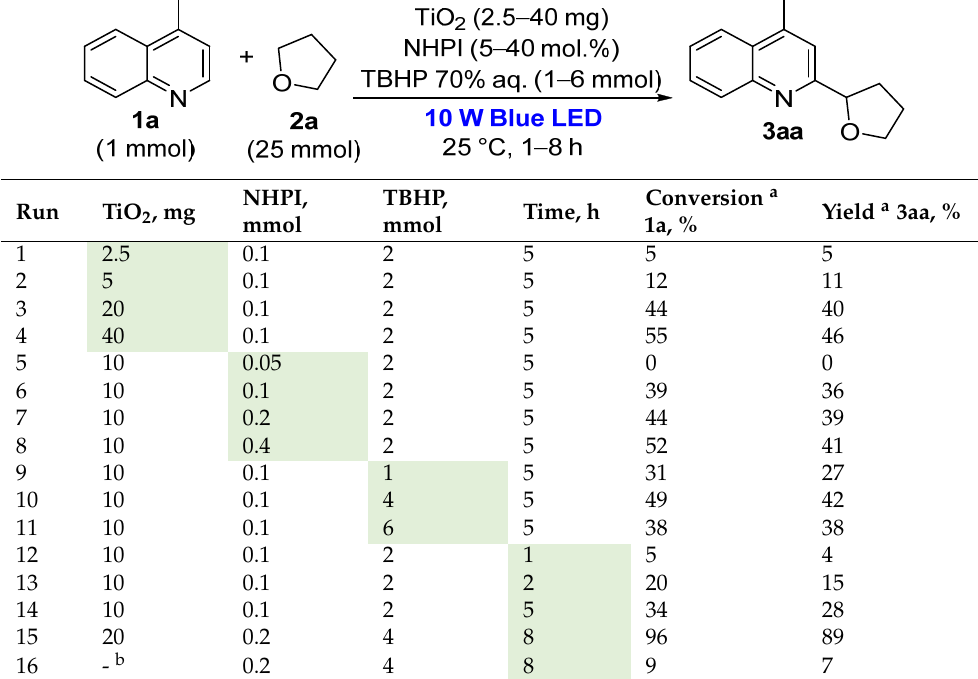
Table 2. Optimization of NHPI/TiO 2 /TBHP ratio and reaction time for the synthesis of 3aa .